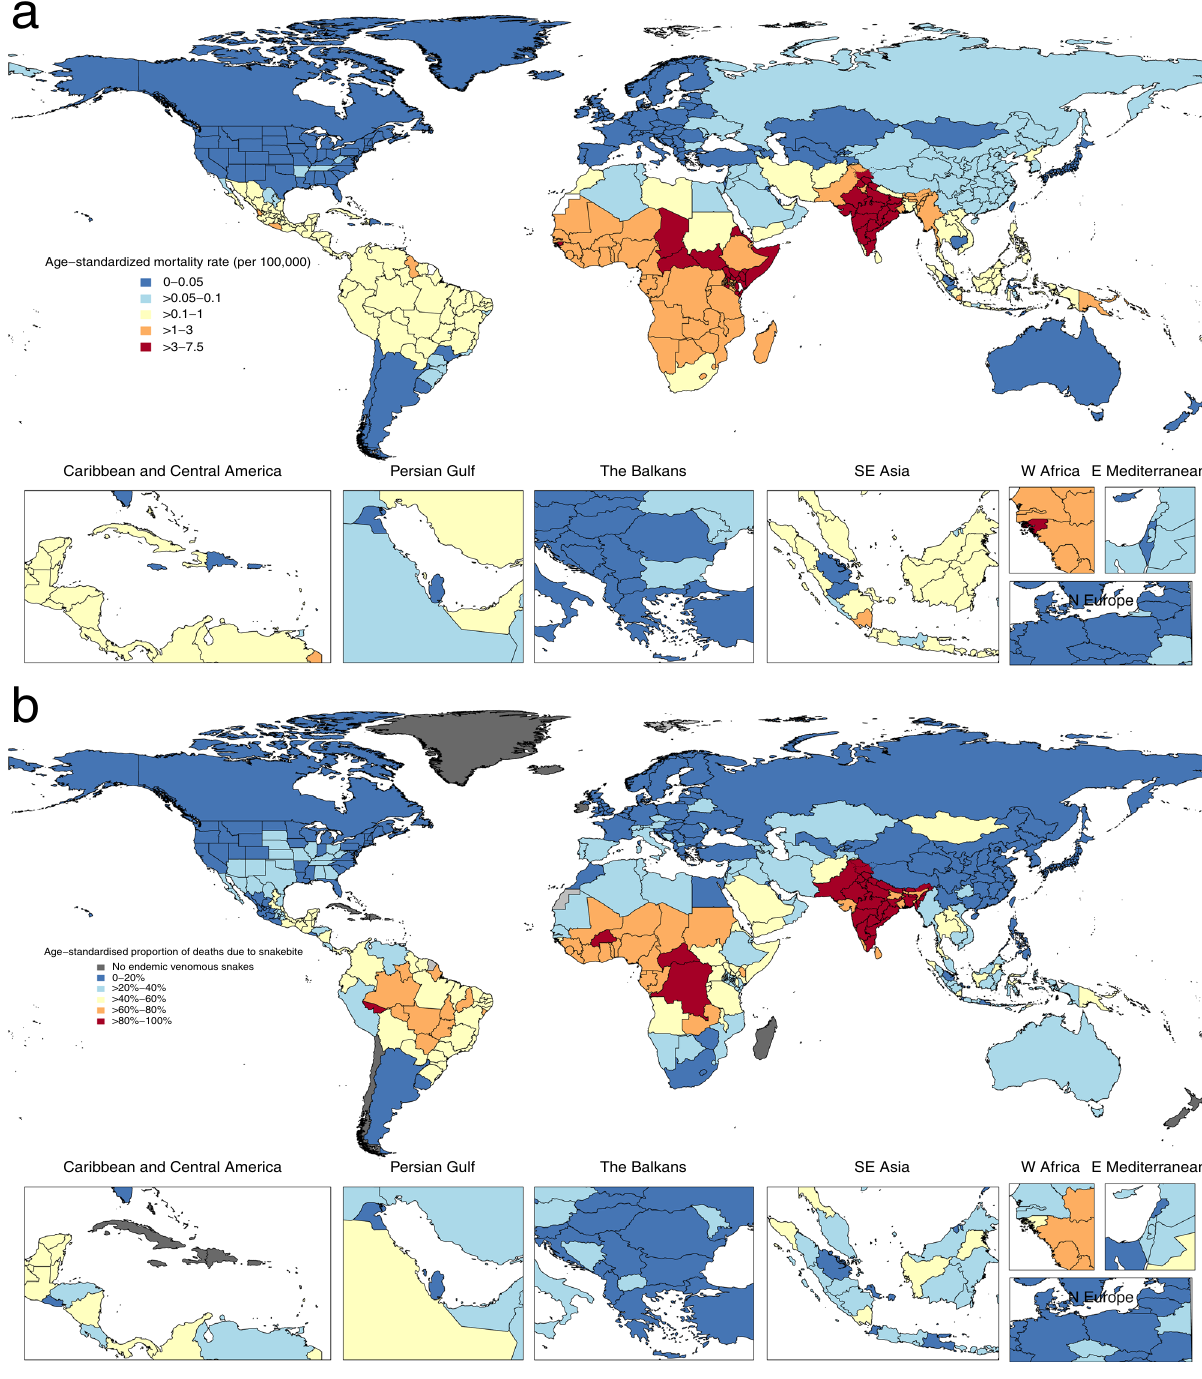
Fig. 5|Age-standardizedmortalityratefromallvenomousanimalcontact and the age-standardized proportion due speci fi cally to snakebite envenoming. a GBD 2019 estimates of the age-standardized mortality rate from venomous animal contact for both sexes combined in 2019. b Estimated age-standardized proportion